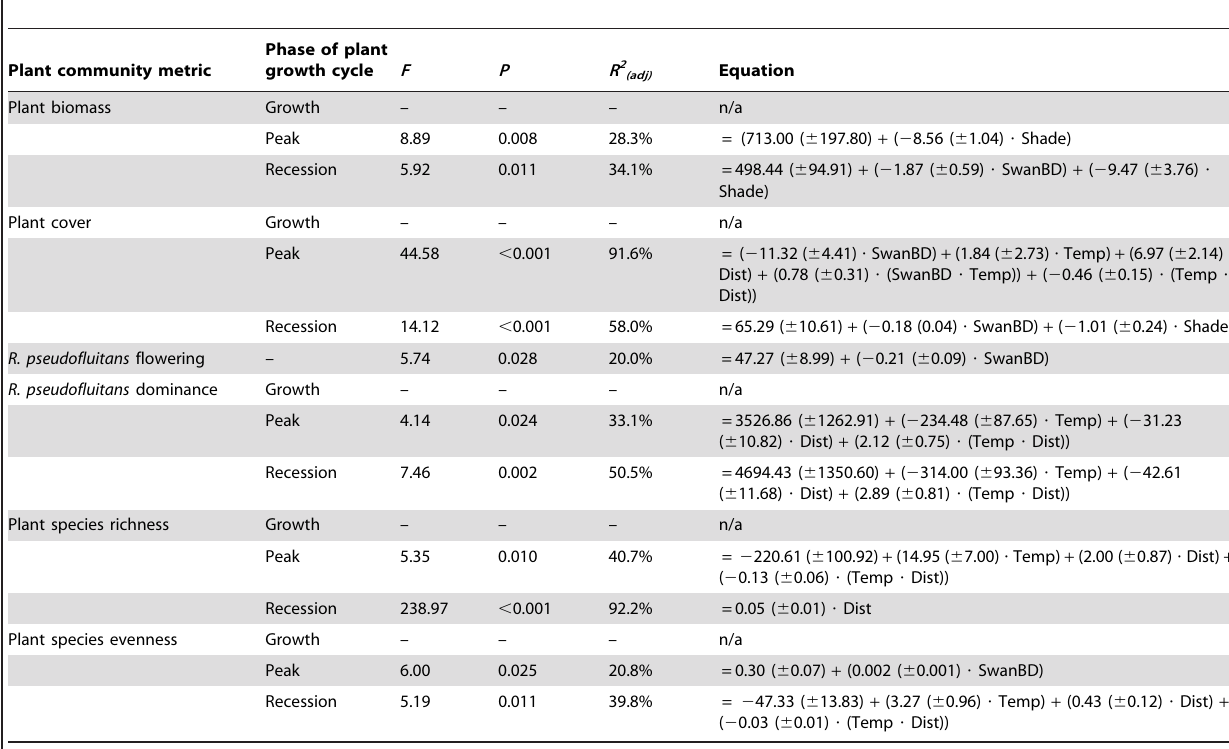
The relevant mean ( 6 SE) parameter values for swan biomass density (SwanBD), shading (Shade), water temperature (Temp) and distance downstream of source (Dist), are given for each equation; n/a indicates that no statistically significant model was